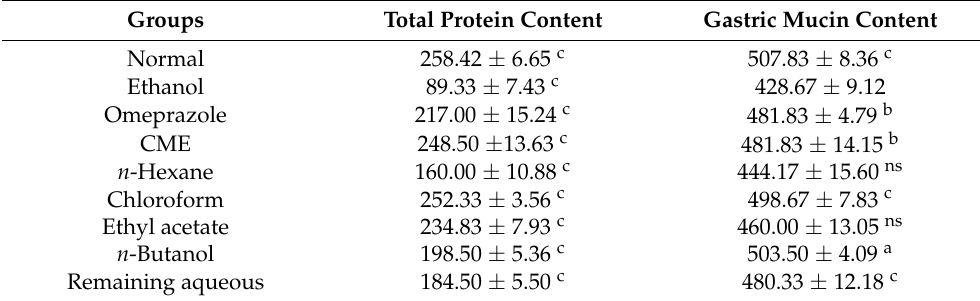
Table 4. Effect of H. crispum CME and different fractions on gastric mucus content and gastric protein